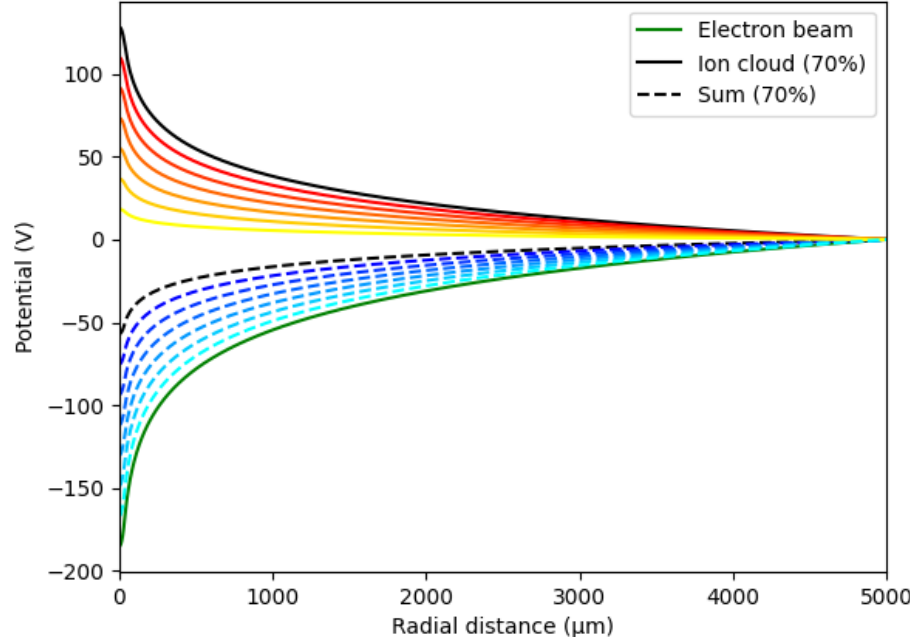
Figure 3. Calculated potential for a heavy ion cloud (Q = 65 + , solid line) and the total potential including an ion cloud and electron beam (dotted line) for various neutralization conditions ranging from 10% (yellow and light blue) to 70% (dark red and dark blue) electron beam neutralization for a beam energy of 18 keV, beam current of 150 mA, and ion cloud temperature of 20